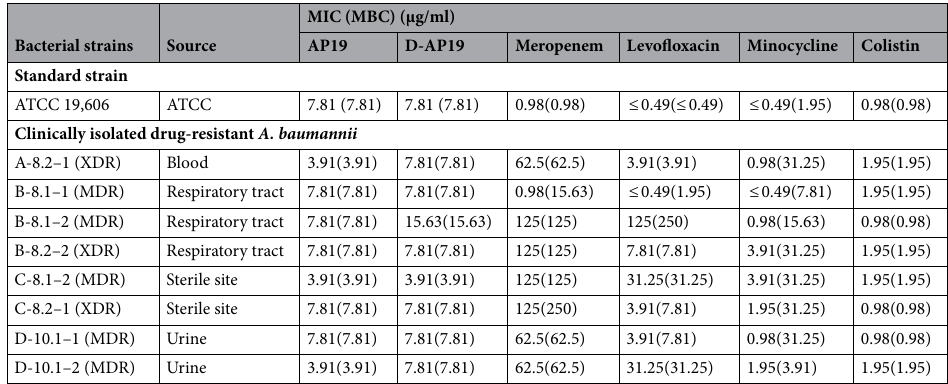
Table 3. Minimum inhibitory concentration (MIC) and minimum bactericidal concentration (MBC) of AP19 and D-AP19 compared to commonly used antibiotics against eight strains of MDR and XDR A. baumannii clinical isolates.